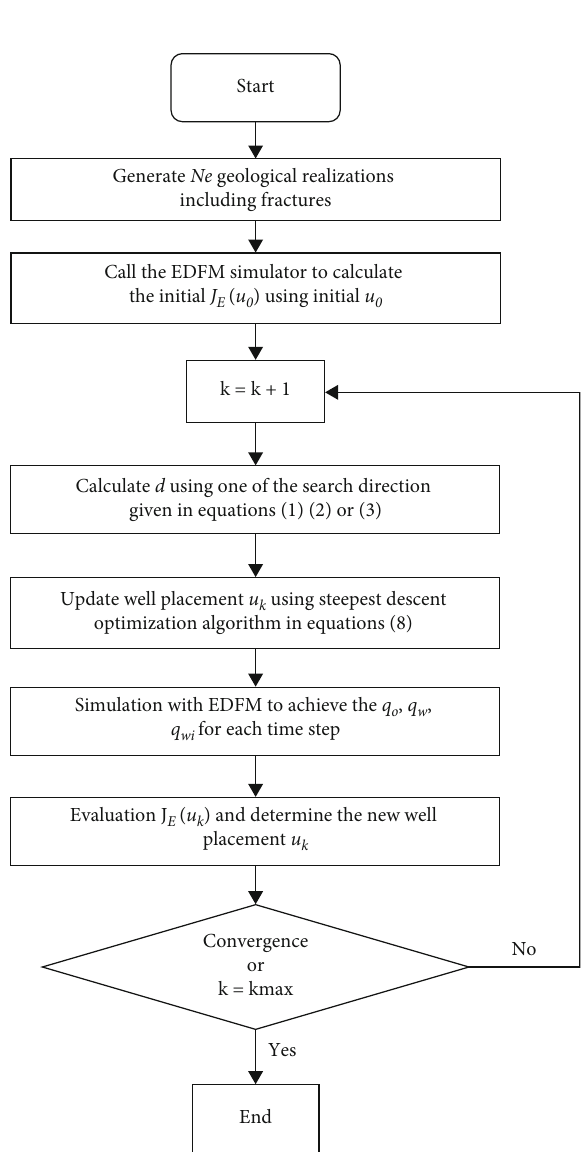
Figure 2: Flow chart of well placement optimization for fractured